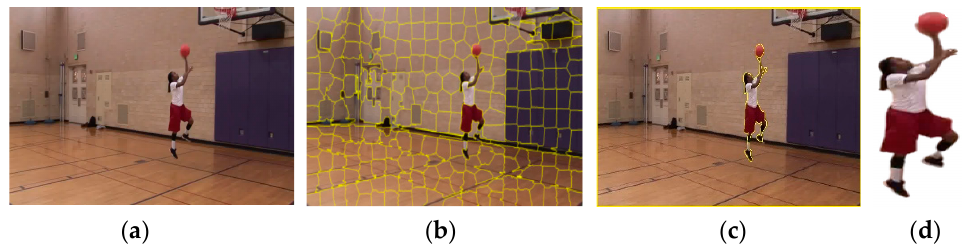
Figure 3. Results of image segmentation. ( a ) Original image, ( b ) super-pixels obtained using quick shift, ( c ) merged super-pixels, ( d ) extracted human–object pair.